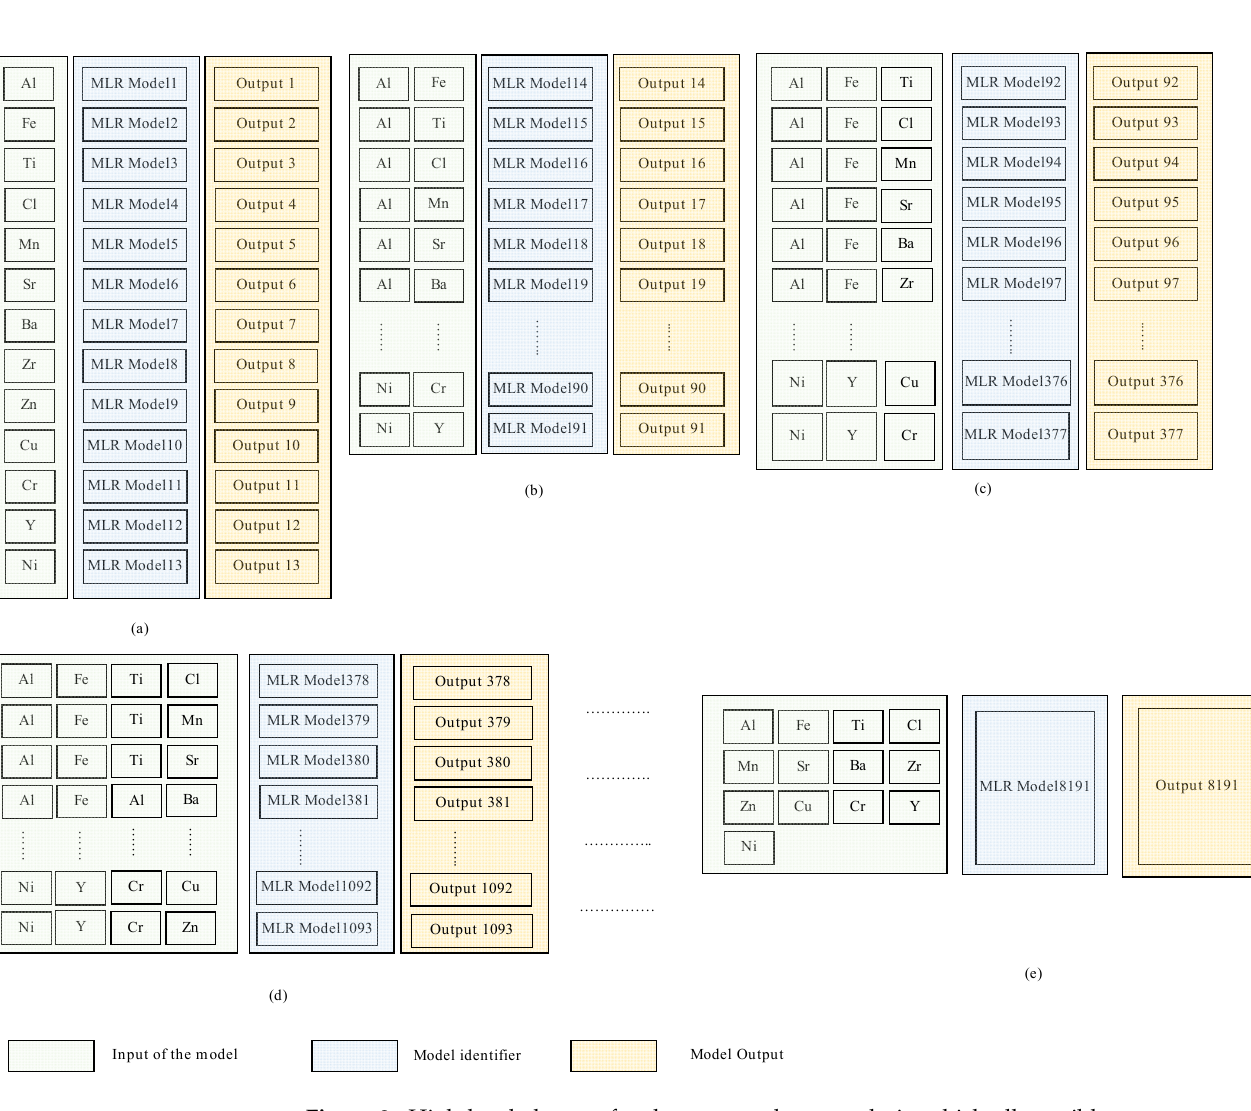
Figure 2. High level abstract for the proposed approach, in which all possible arrangements, to predict the Si microelement are generated, using MLR. ( a ) each microelement except Si has been used individually as explanatory variable, ( b ) two microelements except Si have been used as explanatory variable, ( c ) three microelements except Si have been used as explanatory variable, ( d ) four microelements except Si have been used as explanatory variable, ( e ) all microelements except Si have been used as explanatory variable.